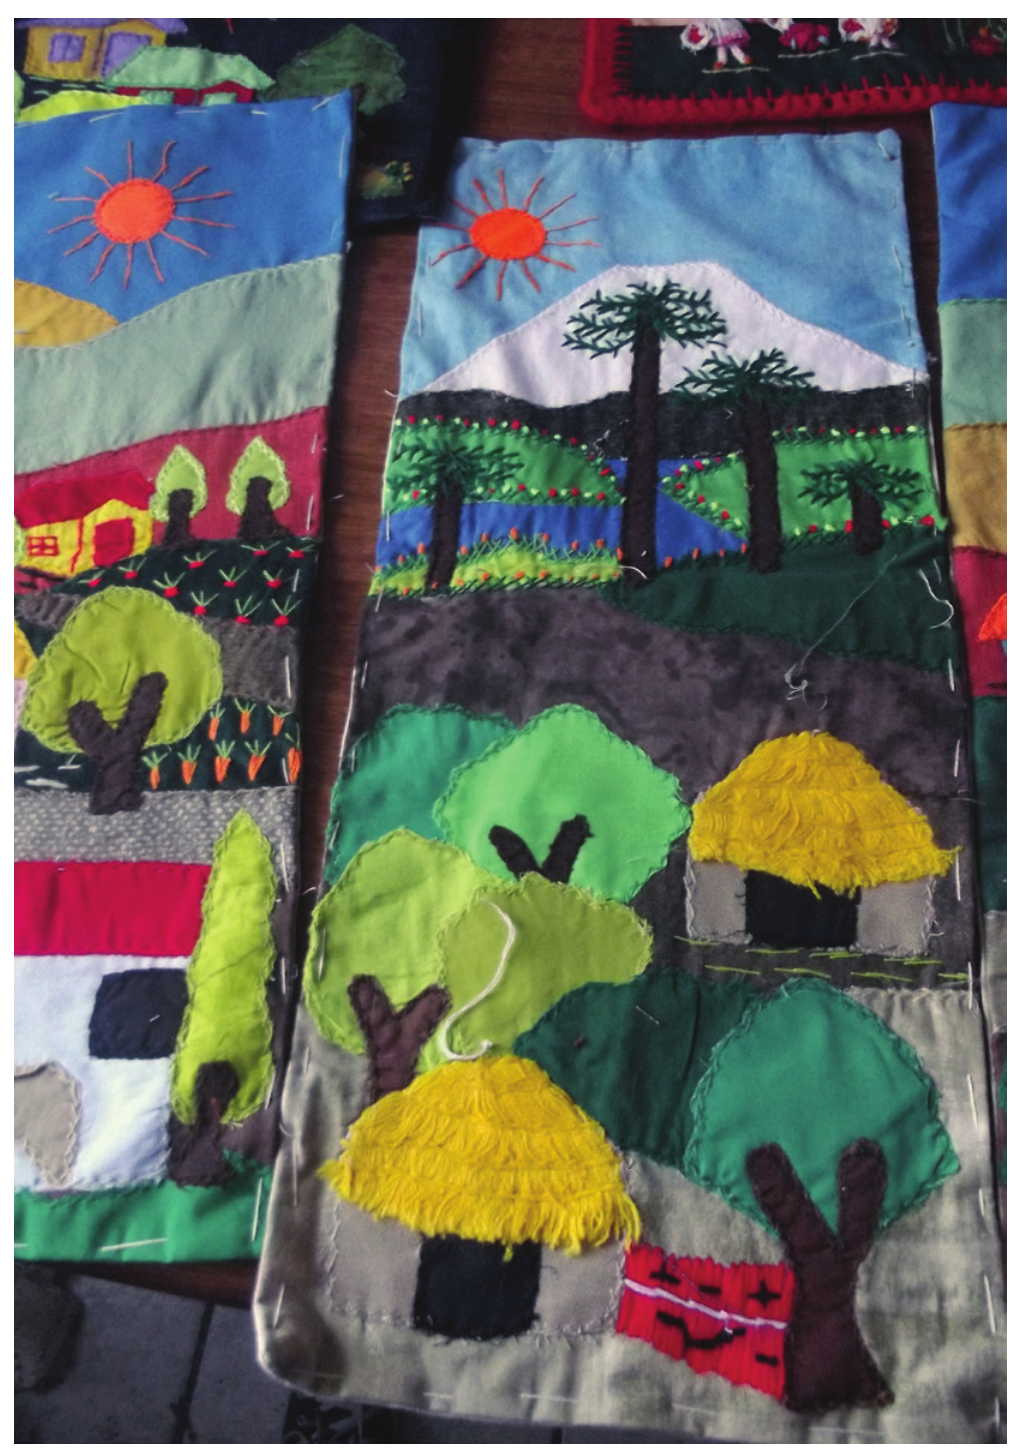
Figure 5: Output research and documentation: María Madariaga (Arpilleras de Lo